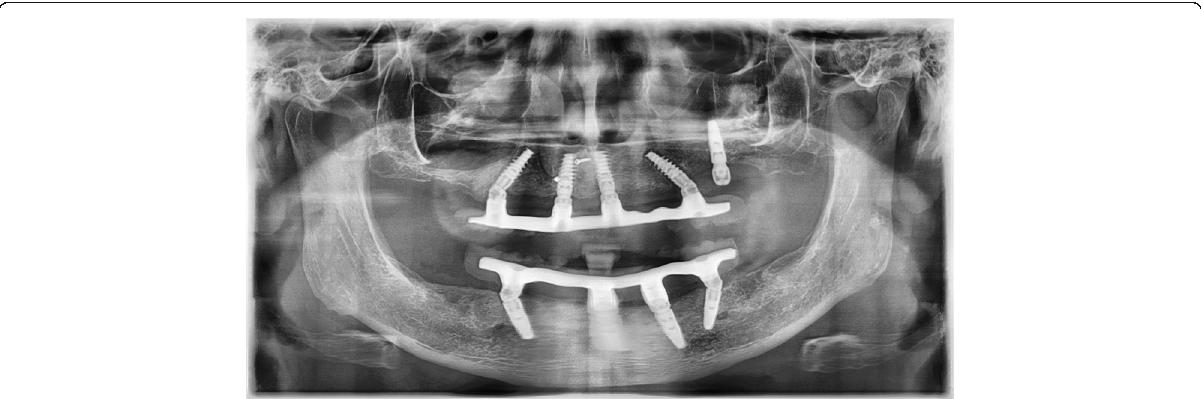
Fig. 2 The procedure of what was done in case of an implant loss. The X-ray shows an All-on-4 restoration on four implants. The angled implant in the 2nd quadrant was loosened. For this reason, another implant with an external sinus elevation was placed in this area. During the entire healing period of this implant, the All-on-4 restoration was fixed on the remaining four implants, so that there was no load on the